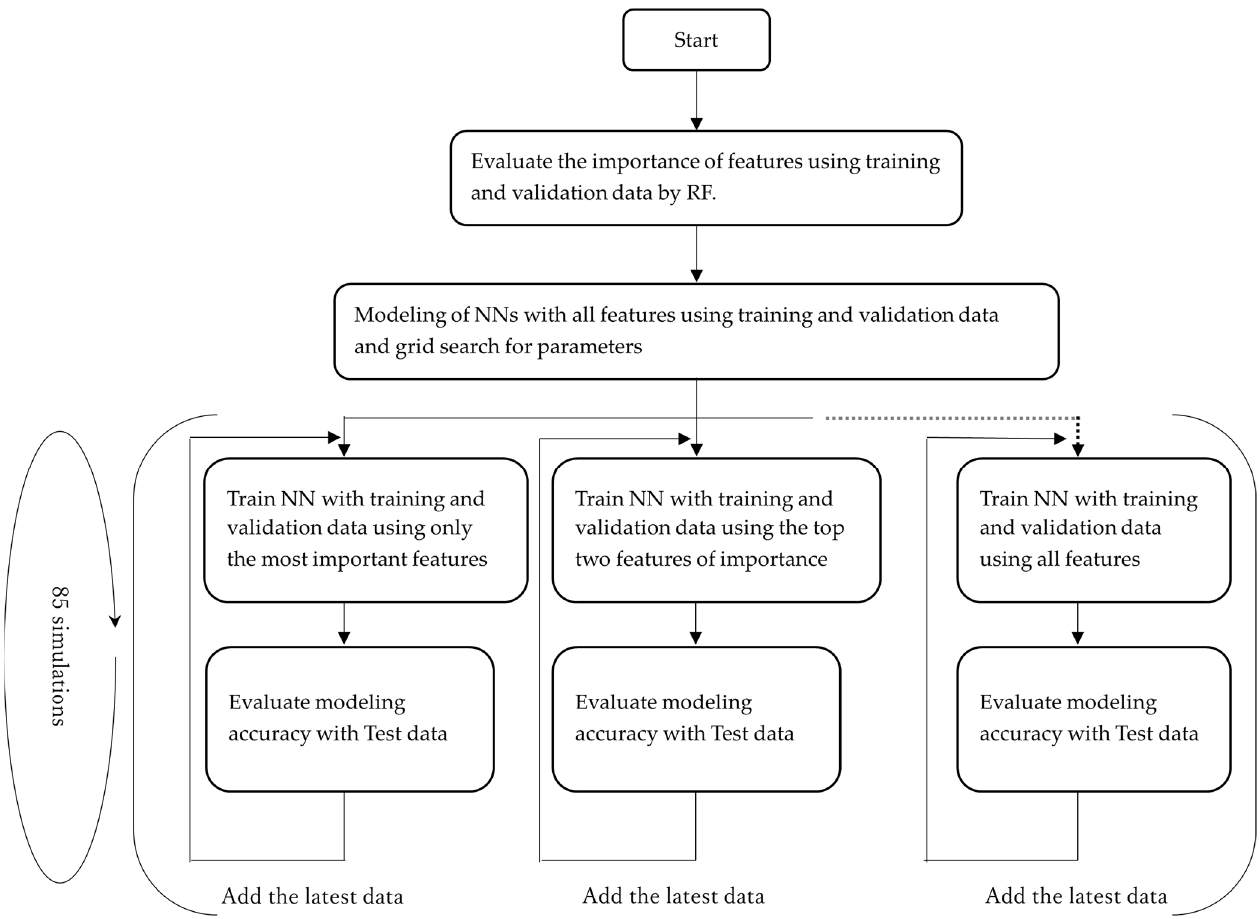
Figure 4. Flowchart of LUBE with feature selection by random forest.